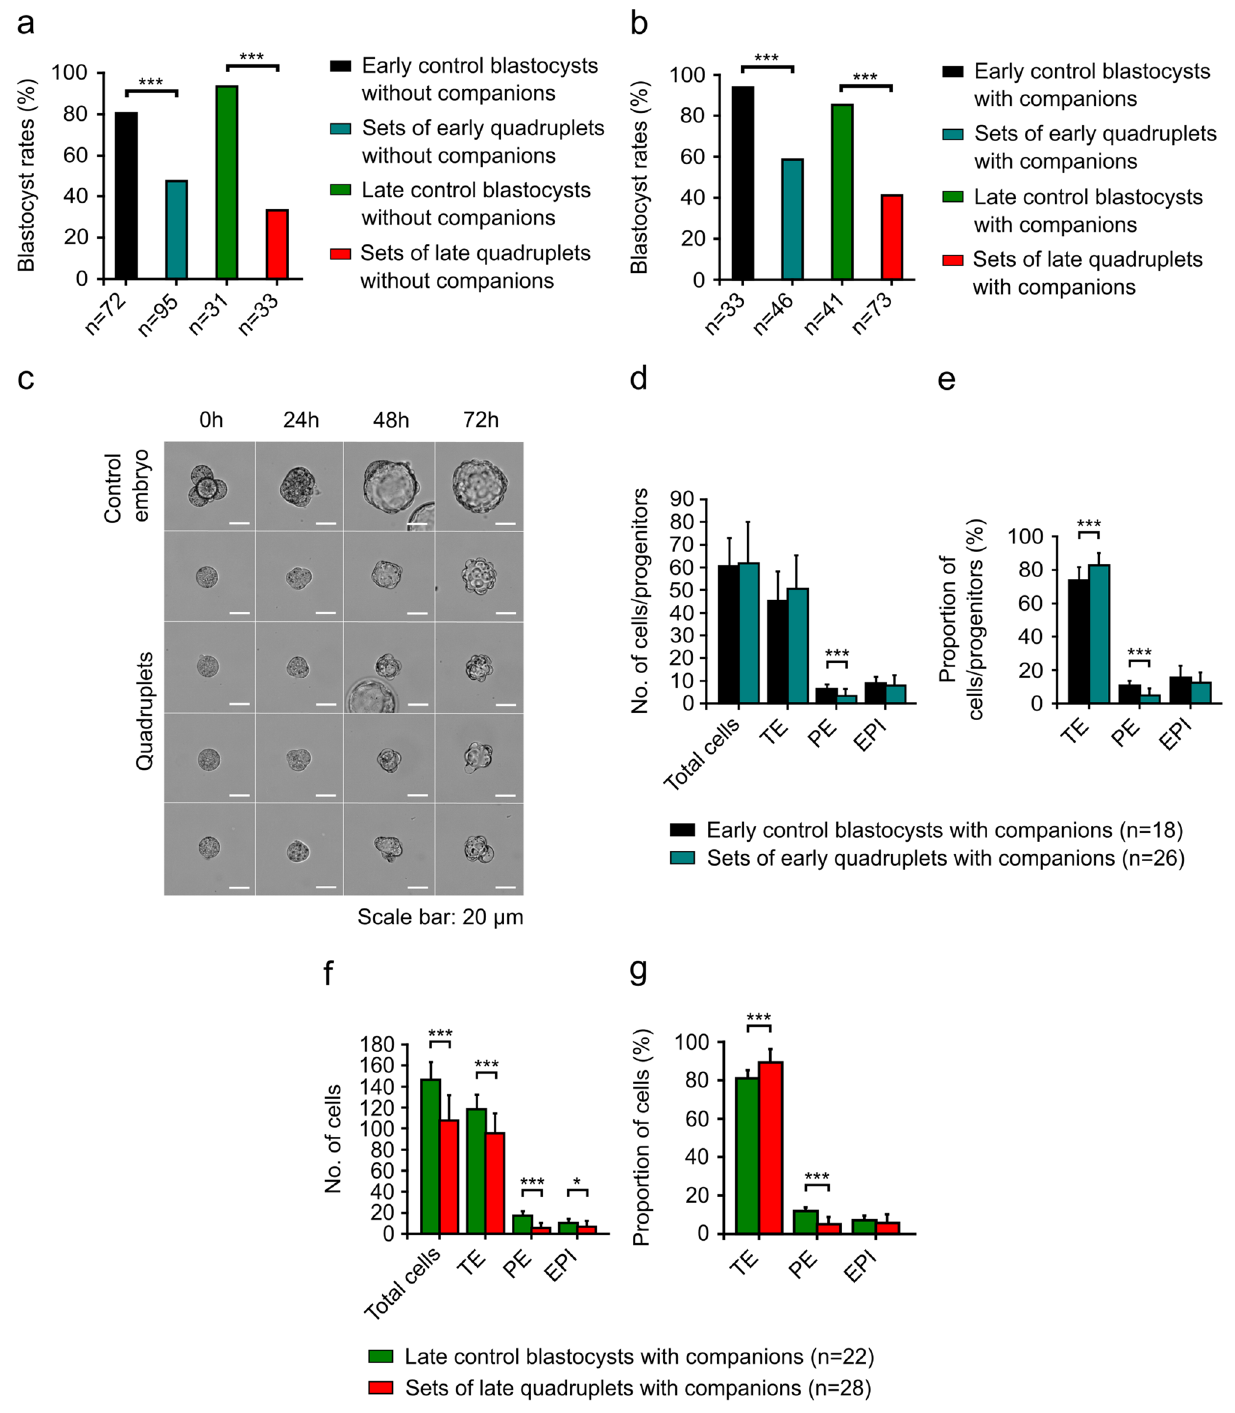
Figure 5. Cell lineage composition in sets of early and late quadruplet blastocysts. ( a ) Blastocyst development from 4-cell stage single blastomeres after 48 (early variation) or 72 (late variation) hours of in vitro culture without accompanying embryos. The experiments were conducted with 13 (for early variation) and 7 (for late variation) replicates. The results were compared with Chi-squared test. *** p < 0.001. ( b ) Blastocyst development from 4-cell stage single blastomeres after 48 (early variation) or 72 (late variation) hours of in vitro culture with accompanying embryos. The experiments were conducted with 6 (for early variation) and 16 (for late variation) replicates. The results were compared with Chi-squared test. *** p < 0.001. ( c ) Representative brightfield images showing embryos developed from 4-cell stage single blastomeres after 24, 48, and 72 h of in vitro culture with accompanying embryos. Scale bar: 20 µm. ( d ) Cell numbers of blastocyst lineages in sets of early quadruplet blastocysts cultured with accompanying embryos. ( e ) Percentage contribution of TE cells, as well as the progenitors of EPI and PE in sets of early quadruplet blastocysts cultured with accompanying embryos. ( f ) Average number of cells contributing to blastocyst lineages in sets of late quadruplets. ( g ) Cell numbers are shown as percentages of the total number of cells in sets of late quadruplets. For ( d , e , f , and g ), normality of the data was verified with the Kolmogorov–Smirnov test, and Student’s t-test was used for calculations. * p < 0.05, ** p < 0.01, *** p < 0.001. Data are represented as mean ± standard